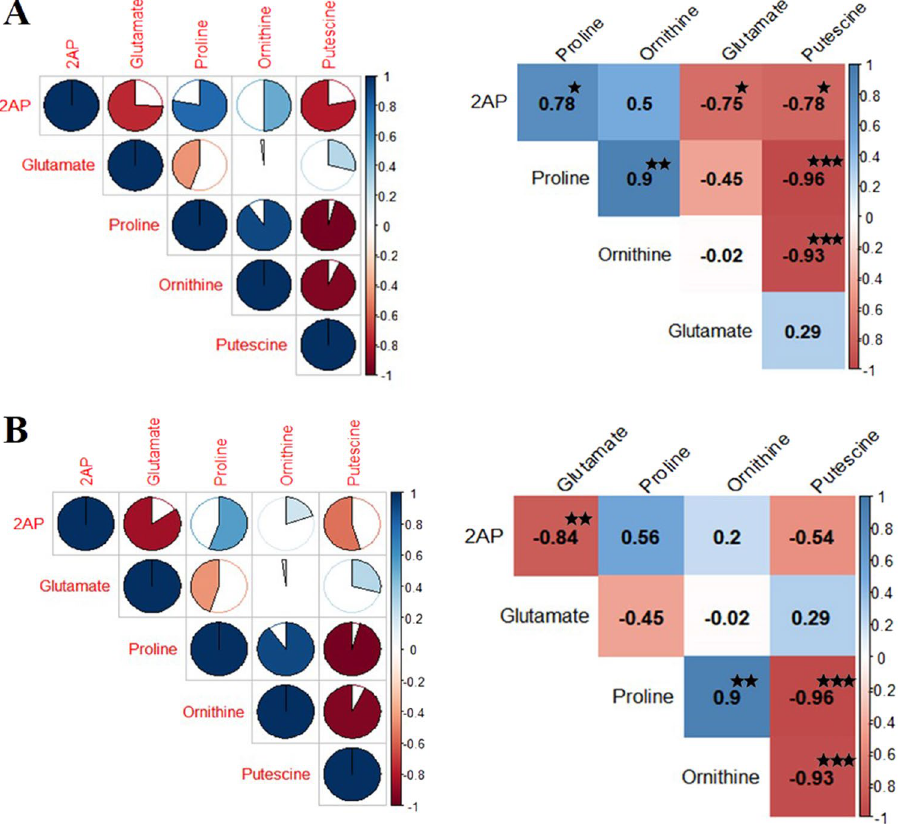
Figure 7. ( A ) Correlation analysis of precursor amino acids with 2AP at vegetative stage ( B ) Correlation analysis of precursor amino acids with 2AP in mature